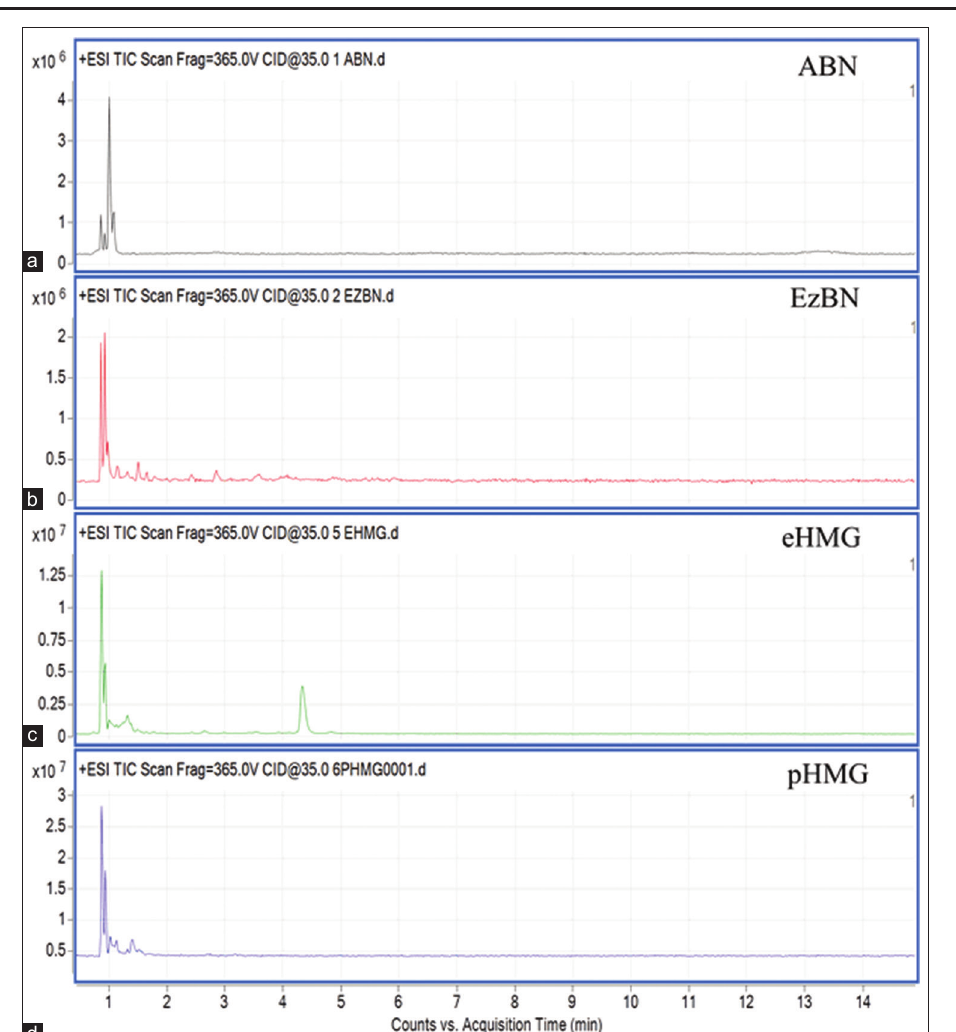
Figure-1: Total ion chromatograms of the first liquid chromatography/mass spectrometry (LC-MS) pre-screening on edible bird’s nest extraction methods (a) ABN, (b) EzBN, (c) eHMG, and (d) pHMG. The LC-MS chromatograms are obtained from